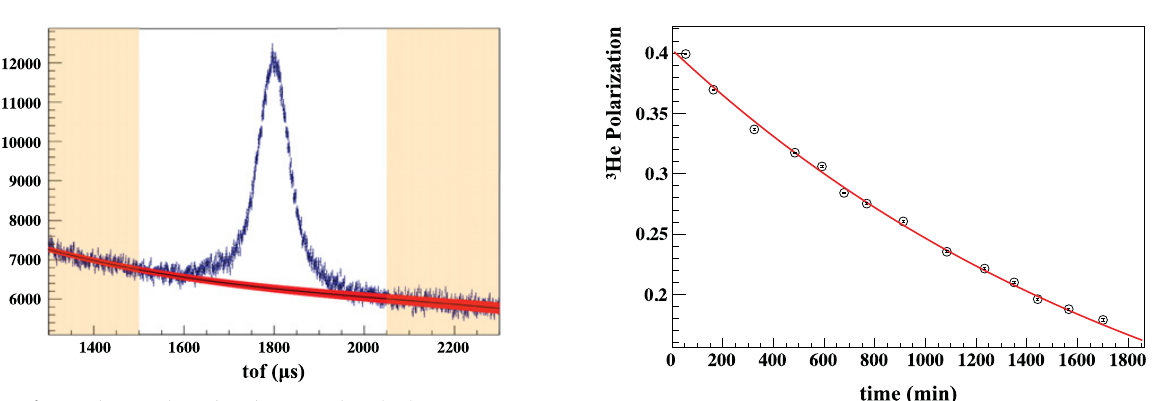
Figure 4. Background estimation at the 0.73 eV p-wave resonance. The orange shaded areas show the regions wherein a cubic polynomial was fit to the data. The red line shows the interpolated background fit with error.